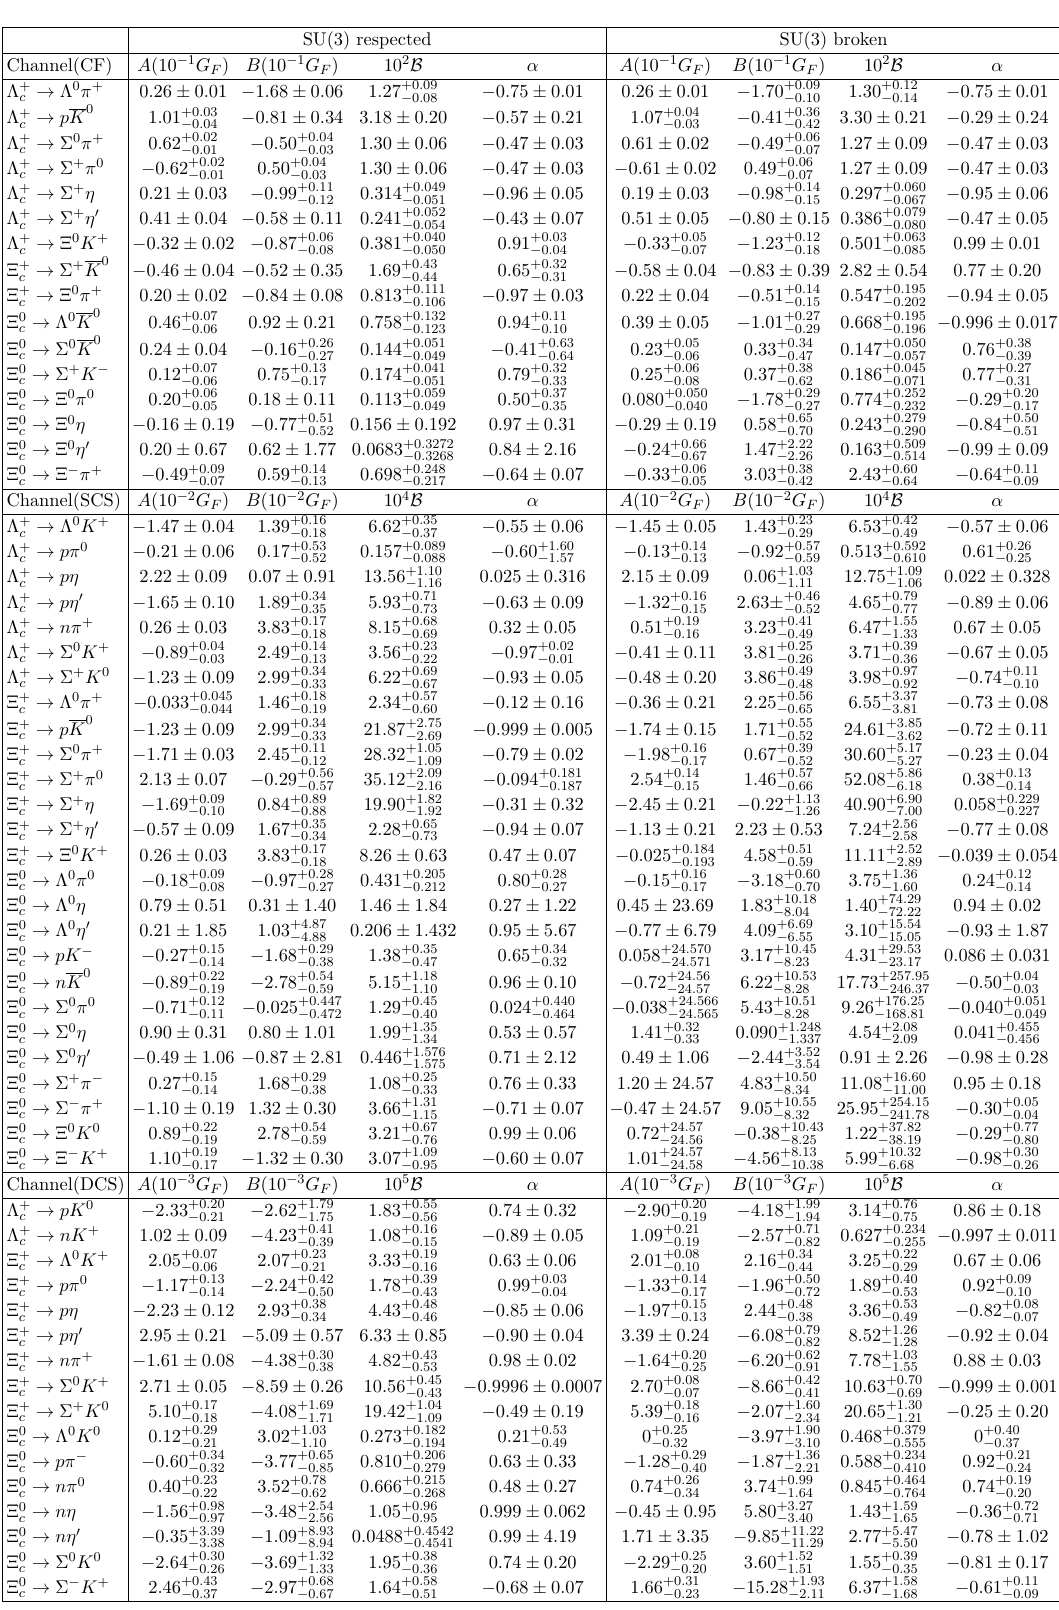
Table 6 . The fitting results of all the weak decays of antitriplet charmed baryons into octet pseudoscalar mesons in both SU (3) flavor symmetry respected and breaking scenarios, including Cabibbo-favored, singly Cabibbo-suppressed and doubly Cabibbo-suppressed